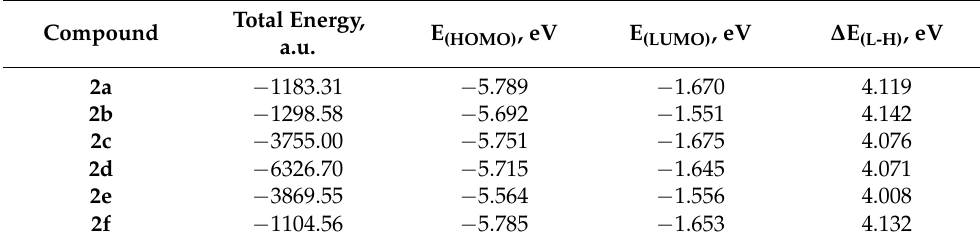
Table 3. Results of quantum chemical calculations for studied compounds 2a – f . Total Energy, Compound E (HOMO) , eV E (LUMO) , a.u.